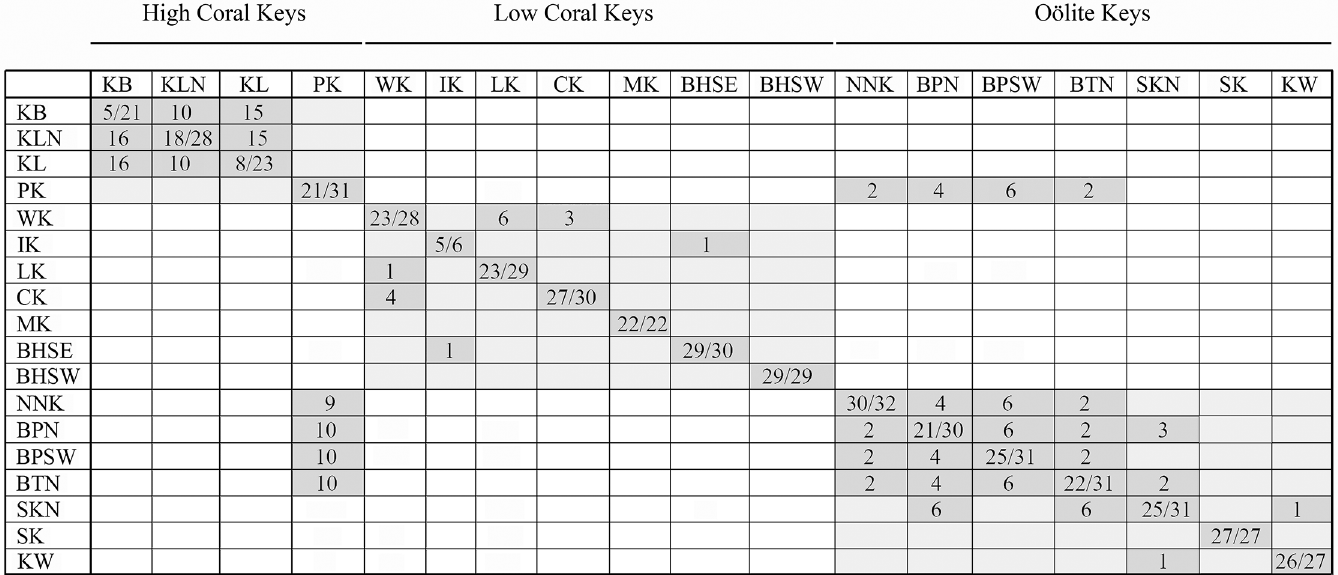
Fig 8. COI haplotypes shared among Keys. Diagonal shows the number of specimens with haplotypes endemic to the Key / number of individuals sequenced from the Key for COI. Rows indicate number of specimens on other Keys that have haplotypes that occur on specified Key. Columns indicate number of specimens on specified Key that share a haplotype with other